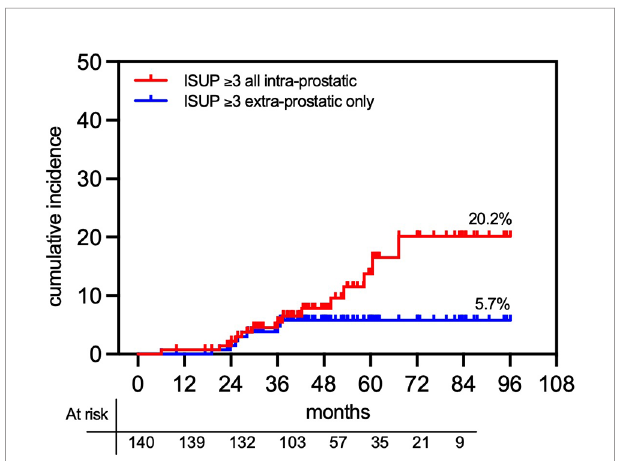
FIGURE 6 | Cumulative actuarial incidence of post-SABR prostate cancer relapse in histological ISUP ≤ 3 group. Relapse was detected by 68 PSMA PET/CT scanning detecting intraprostatic (± extraprostatic) lesions vs. extraprostatic only tumor lesions.